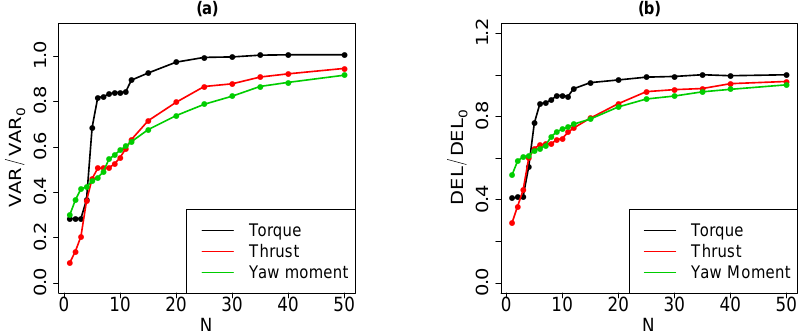
Figure 10. PSDs of the different loads for original LES and truncated PODs including different numbers of modes N .